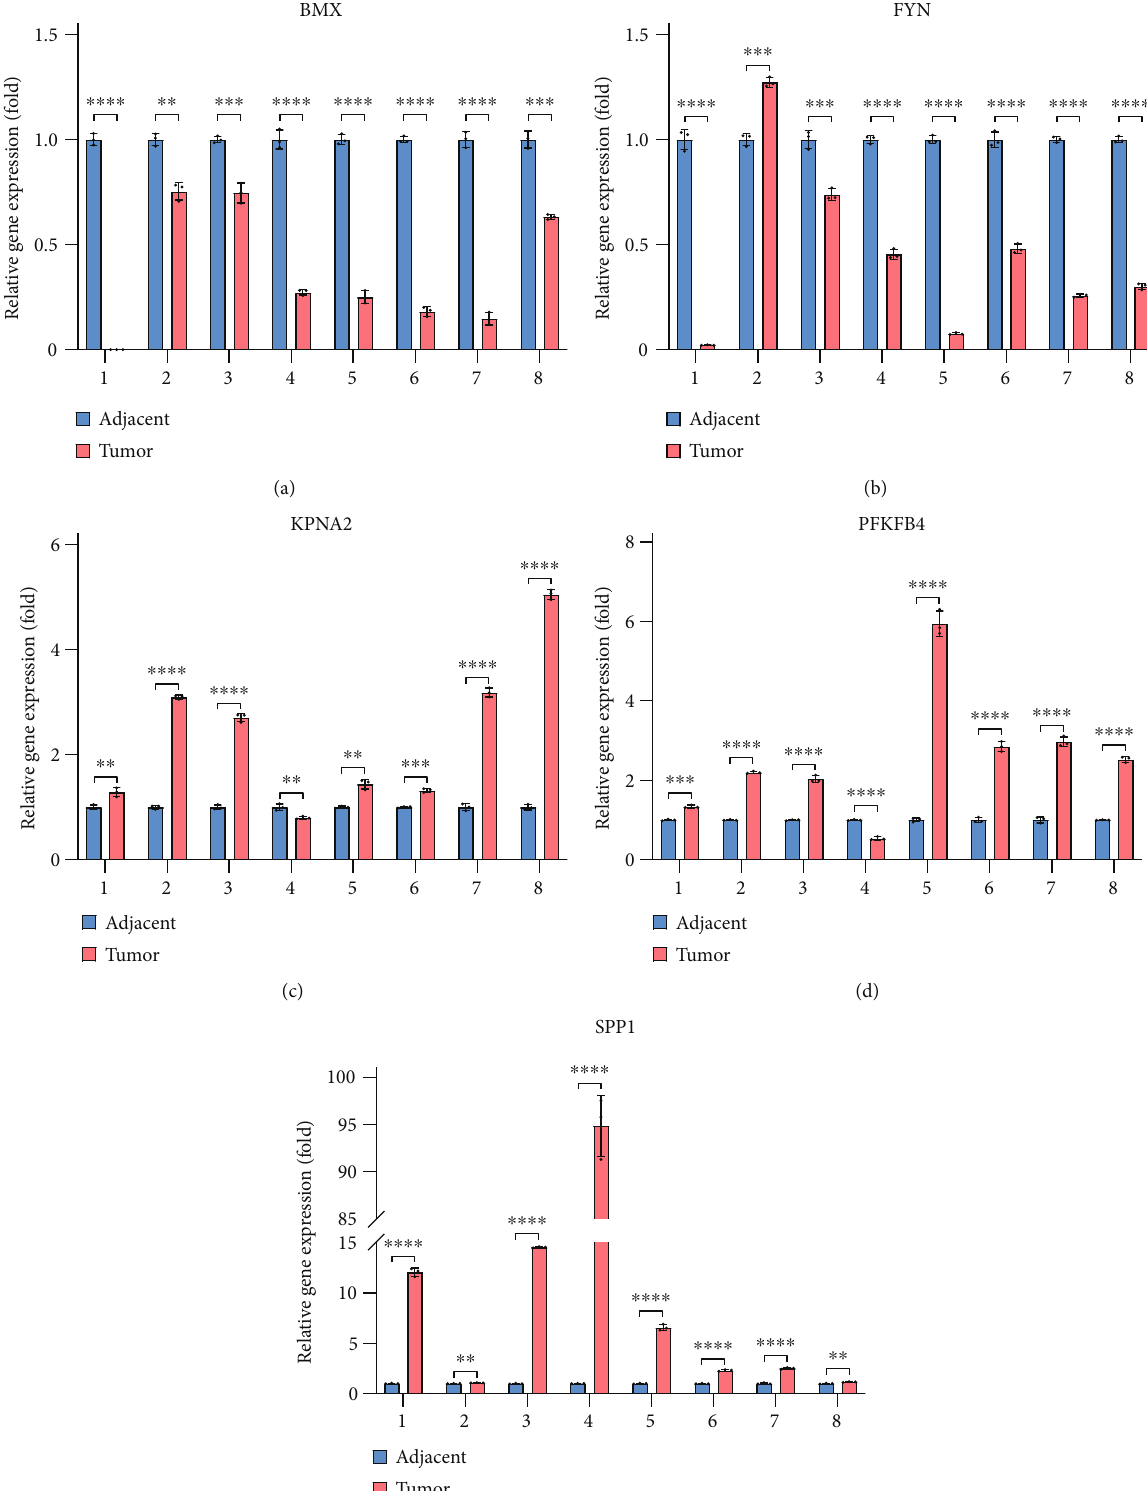
Figure 6: qRT-PCR of eight pairs of tumour tissues and adjacent normal tissues from patients with HCC. (a) Relative gene expression of BMX . (b) Relative gene expression of FYN. (c) Relative gene expression of KPNA2 ; (d) Relative gene expression of PFKFB4. (e) Relative gene expression of SPP1. * P < 0 : 05 ; ** P < 0 : 01 ; *** P < 0 : 001 ; and **** P < 0 : 0001